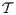
Chronological and retrospective probabilities of single-cell lineages.A. Chronological and retrospective probabilities on a fixed tree. Here we consider a representative fixed lineage tree T spanning from time t0 to t1 = t0 + τ. The number of cells in this tree at t1 is N(t1,T)=13 cells, and each of these cells distinguishes a unique lineage (e.g. the cyan and orange lines in the tree). πicl is the probability that a cell lineage i (i=1,2,⋯,N(t1,T)) is chosen by descending the tree from t0 to t1 (green arrow). At every division point, we randomly select one daughter cell’s lineage with the probability of 1/2 (light green arrows). The probability that we choose lineage i in this manner is πicl=2-Di, where Di is the number of cell divisions on lineage i. πirs is the probability of choosing cell lineage i among N(t1,T) lineages with equal weight (pink arrow). Thus, πirs=N(t1,T)-1. We call πicl and πirs the chronological probability and retrospective probability, respectively, based on the time directions of the green and pink arrows. The chronological and retrospective probabilities for the cell lineages 3 and 9 are shown in cyan and orange texts, respectively. B. A tree on which all the cell lineages have the same number of cell divisions. In this case, the chronological and the retrospective probabilities are equal for all the lineages. C. General case with a large collection of lineage trees. Ti denotes a tree each descended from a different ancestor cell at time t0. The definitions of the chronological and retrospective joint probabilities of division count D and lineage phenotype x are shown in green and pink, respectively. n(D, x) denotes the total number of cell lineages with D and x, i.e. n(D,x)=∑T n(D,x,T).